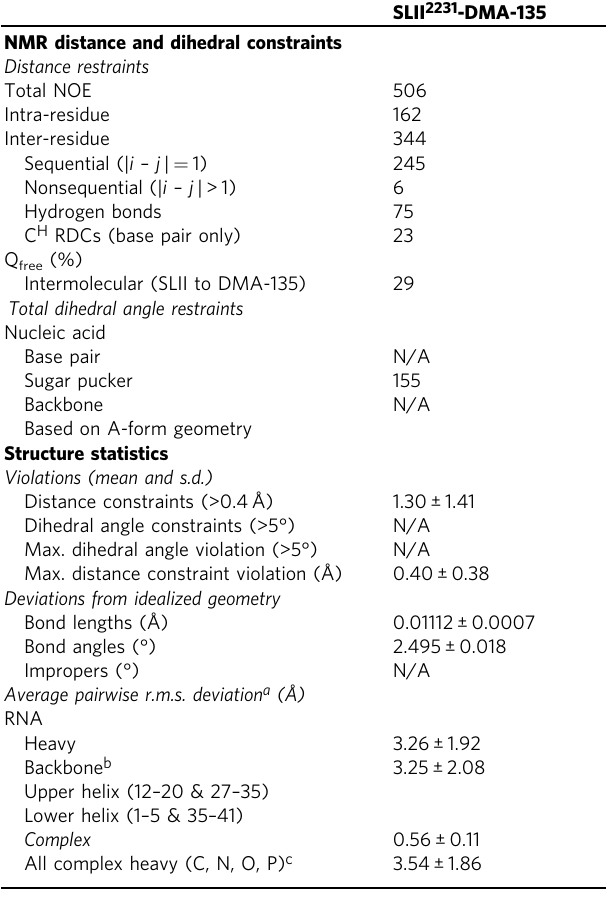
a Statistics were calculated and averaged over an ensemble of the 10 lowest energy structures. b Pairwise r.m.s deviation for backbone was calculated with alignment of C3 ’ , C4 ’ , C5 ’ , O3 ’ , O5 ’ , and P atoms. c Pairwise r.m.s deviation for complex was aligned with base pair